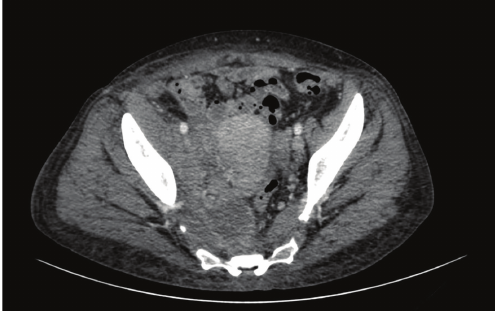
Figure 2: Computed tomography (CT) scan showed the mass occu- pying the extraperitoneal space infiltrating the psoas muscle poste- riorly and the pelvis anteriorly.